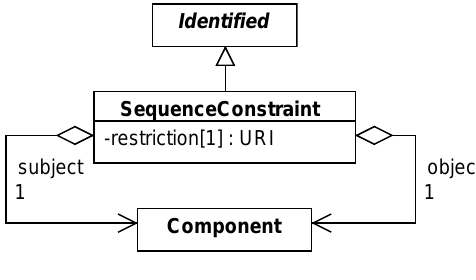
Figure 13: Diagram of the SequenceConstraint class and its associated